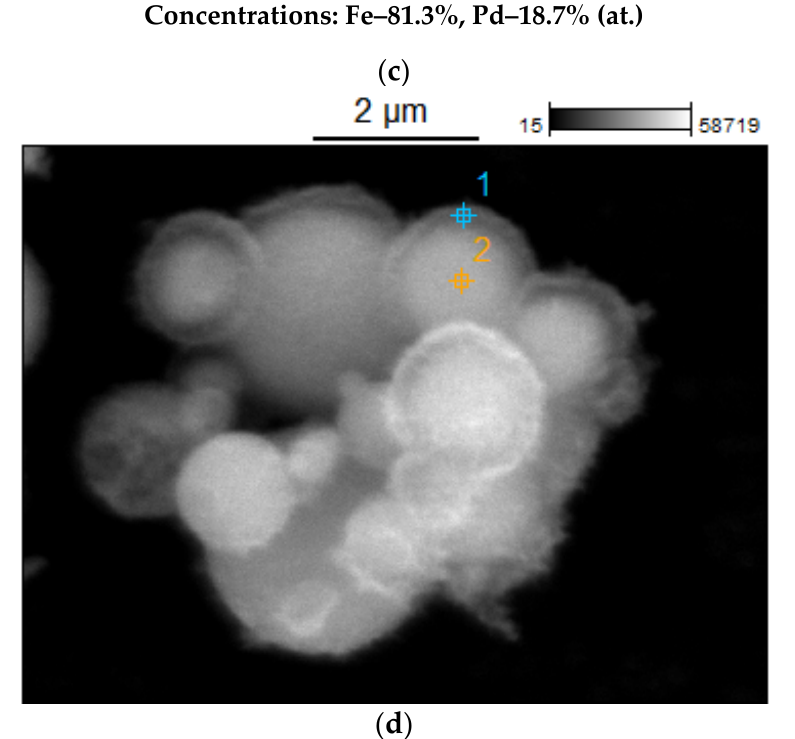
Figure 5. ( a , b ) Morphology of the Fe@Pd core–shell particles obtained by galvanic replacement reaction, different magnifications, ( c ) energy-dispersive spectroscopy (EDS) of the Fe@Pd core–shell particles obtained by galvanic replacement reaction, ( d ) cross-section of the core–shell particles (concentration of Pd in point 1 is higher than in point 2, as determined by EDS).